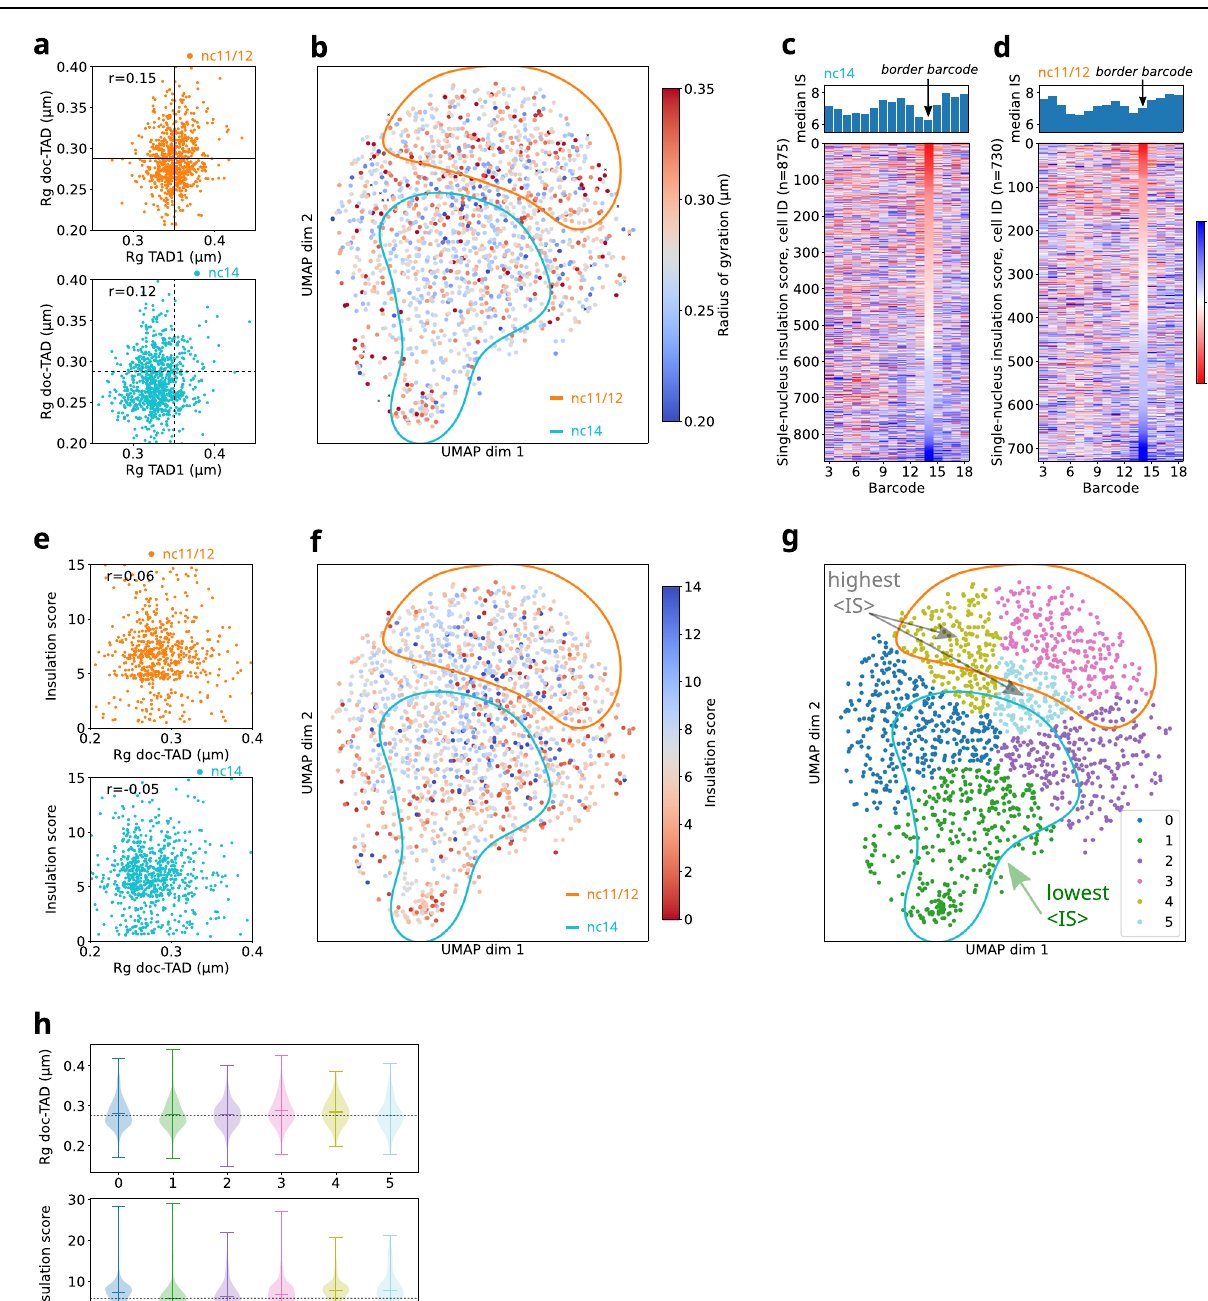
Fig. 2 | Segregation of nuclei populations in the UMAP space is due to a com- bination ofmultiplearchitectural features. a Top: scatter plot of the correlation between radii of gyration for doc-TAD and TAD1 in nc11/12 nuclei. Each point representsasinglenucleus( n =713).Horizontalandverticallinesindicatethemean of the distribution. r is the Pearson correlation coef fi cient. Bottom: same but for nc14( n =837).Dashedlinesindicatethemeanofnc11/12. b SameUMAPasinFig.1i, color-coded by the radius of gyration of the doc-TAD. Blue and red correspond to small and large radii, respectively. c Top: Ensemble-average (median) pro fi le of the insulationscorefornc14.Blackarrowindicatestheborderbarcode.Bottom:single- nucleusinsulation score. Each line corresponds to the insulationscorepro fi le of an individual nucleus, with values color-coded from red (small insulation score, i.e., stronginsulation)toblue(largeinsulationscore,weakinsulation).Thecolorscaleis the same asin e . Nuclei aresorted according to their insulation scoreat the border barcode.Numberofnuclei: n =875. d Similarto d ,butfornc11/12nuclei.Numberof